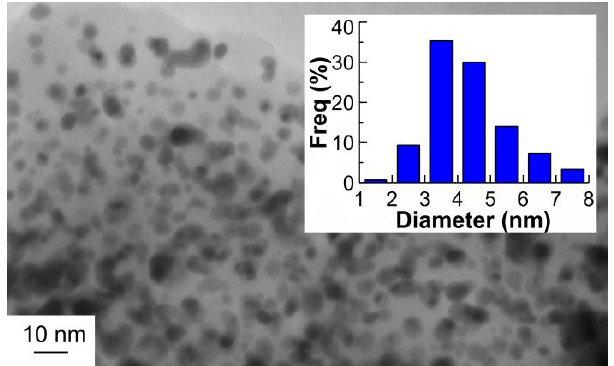
Figure 2. TEM image of the Pt nanoparticles supported on SiO 2 with their diameter distribution.